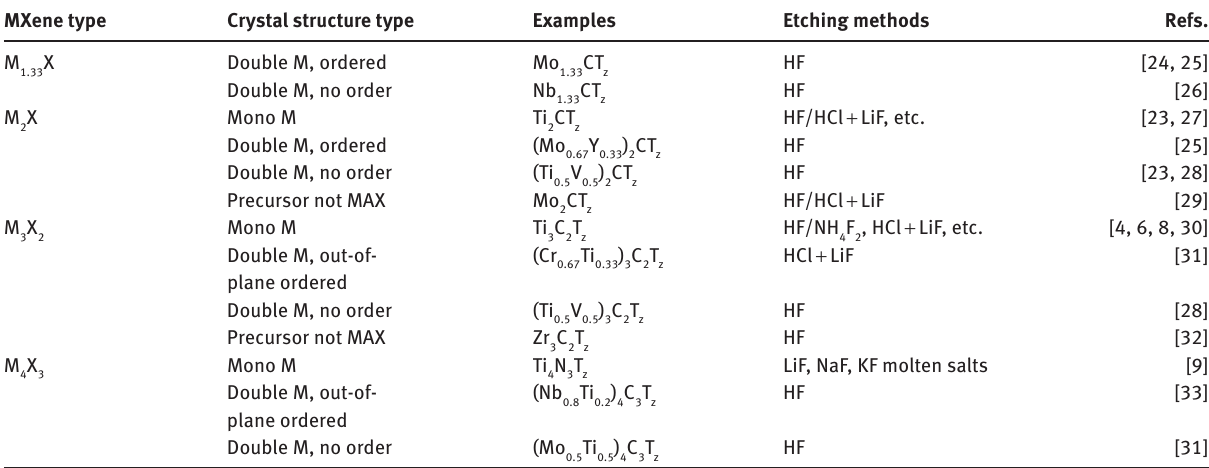
Table 1: Examples of MXenes in different structures, one or some etching methods, and corresponding references. MXene